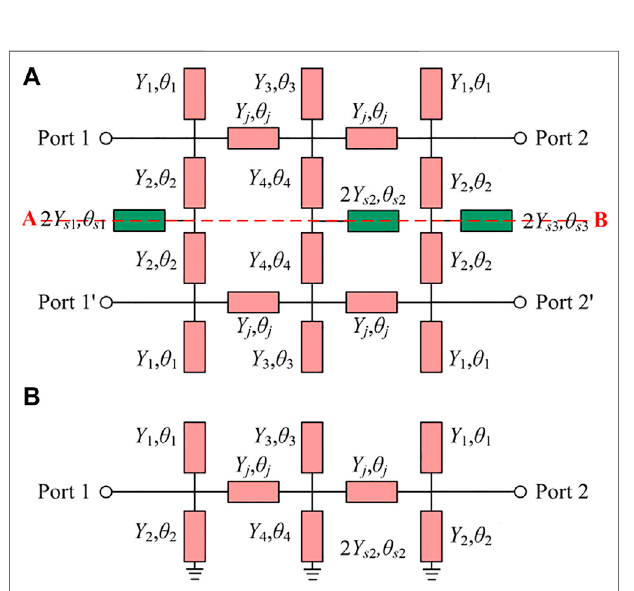
FIGURE4| Calculatedparametersof Figure3B atdifferentfrequencyratios (A) Therelationshipbetween Δ 1 andcharacteristicimpedance Z U 1 (B) Therelationship between Δ 1 and characteristic impedance Z L 1.